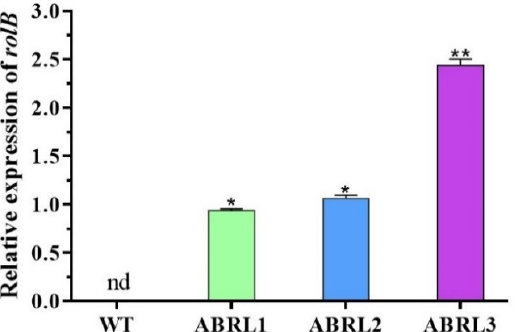
Figure 2. Relative expression of rolB gene in wild type and three independent transgenic lines of A . bracteosa . The expression level was normalized with the β -actin and 18s reference genes. Data are expressed as mean ± S.D. (** p < 0.01, * p < 0.05), nd = not detected.